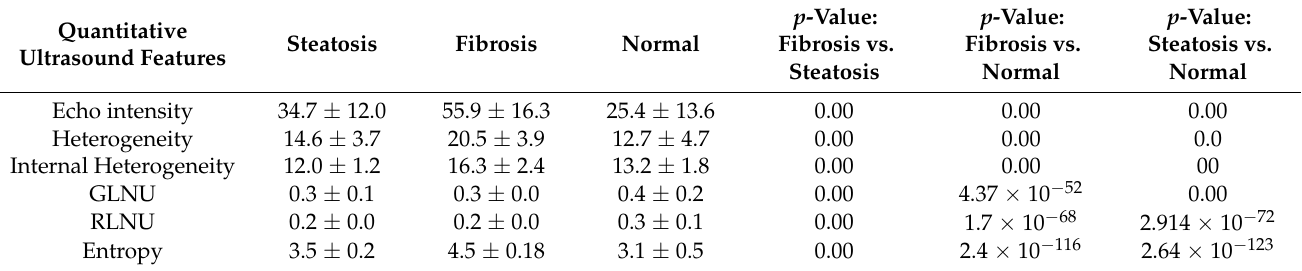
Table 1. Mean ± standard errors of liver texture ultrasound features studied for the three liver pathologies. Two-sided t -test p -values are shown for each group against the other two groups. p < 0.05 is considered significant.